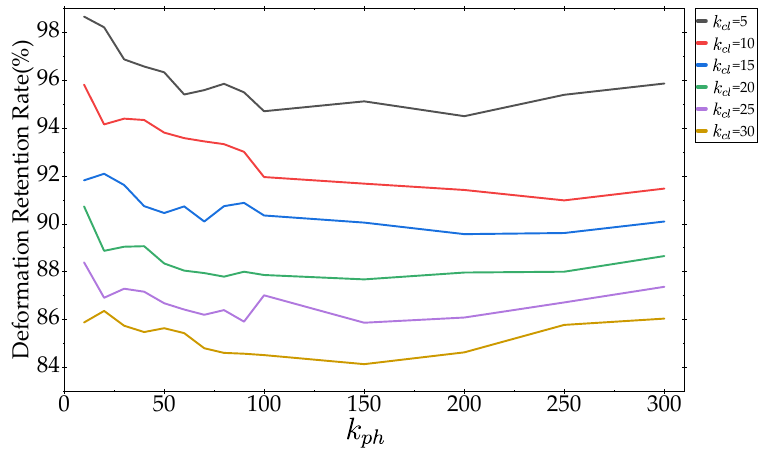
Figure 20. Deformation retention rate (DRR) curves under different parameter combinations.